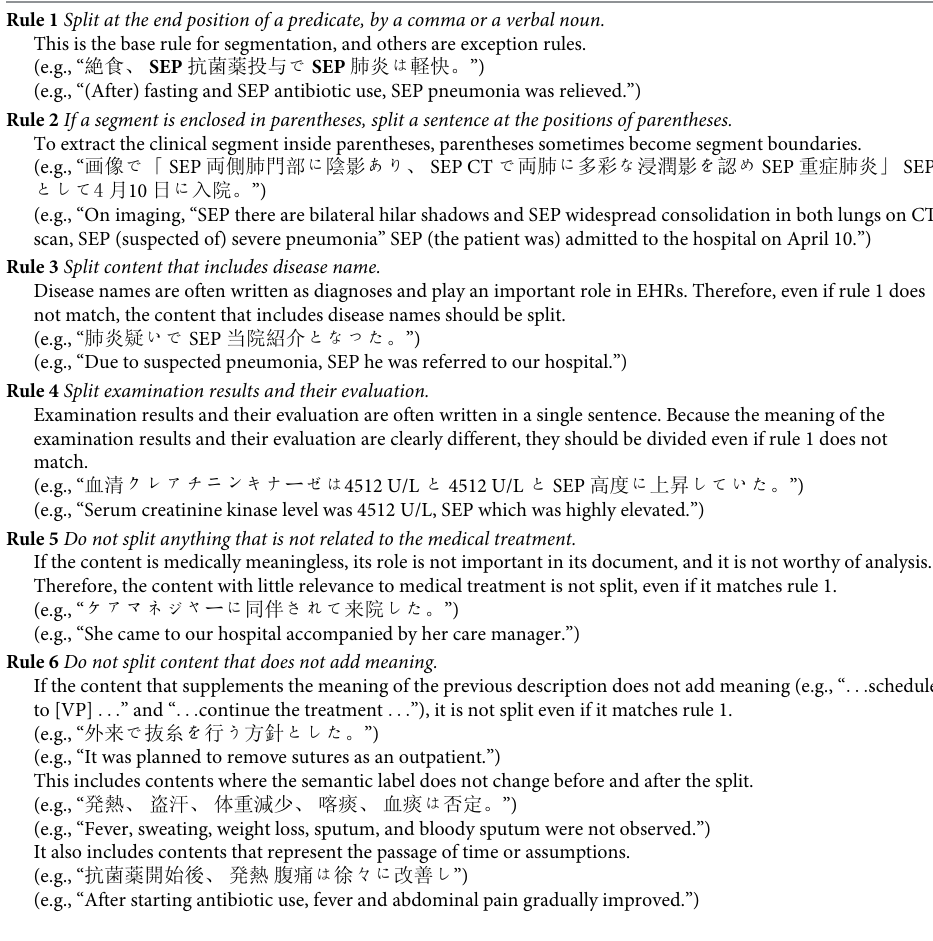
Table 3. Segmentation